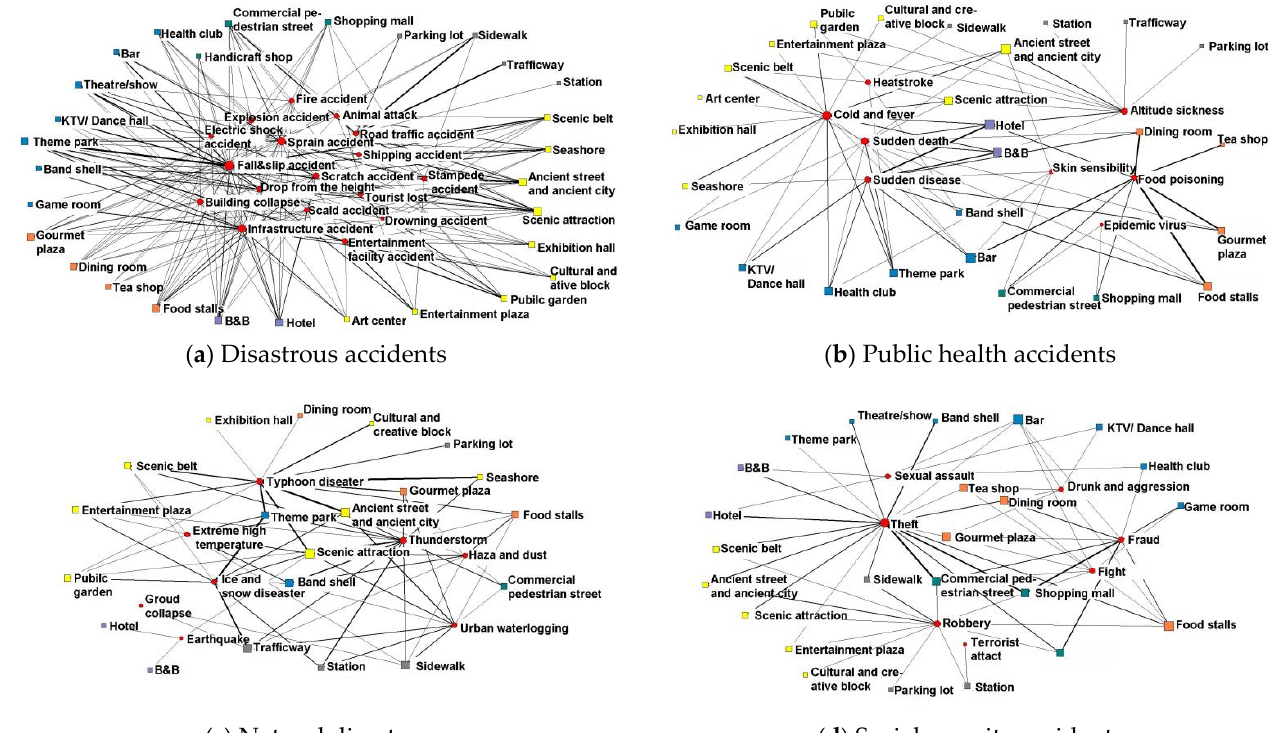
Figure 6. Correlation characteristics of site-accident types.